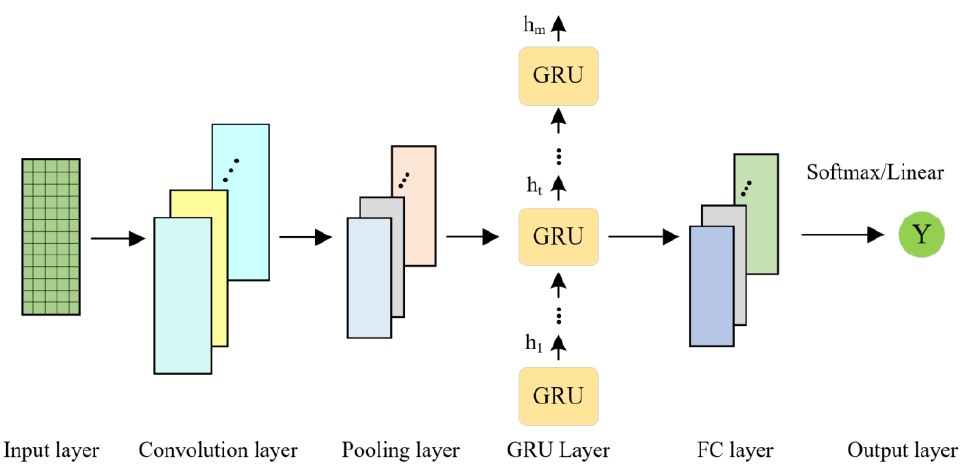
Figure 2. Structure of the CNN-GRU model.